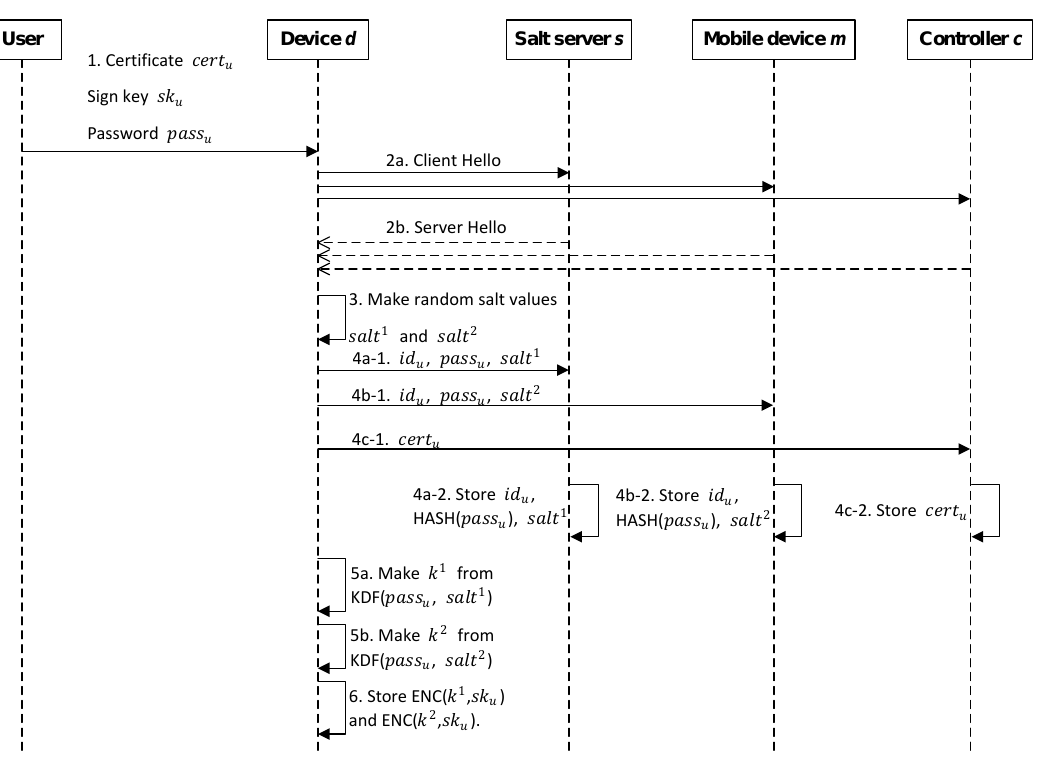
Figure 2. Encryption key generation